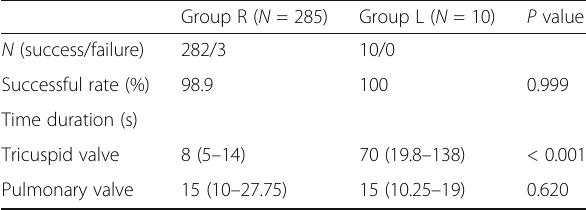
Table 2 Successful rate and the time duration to advance the pulmonary artery catheter through the tricuspid and pulmonary